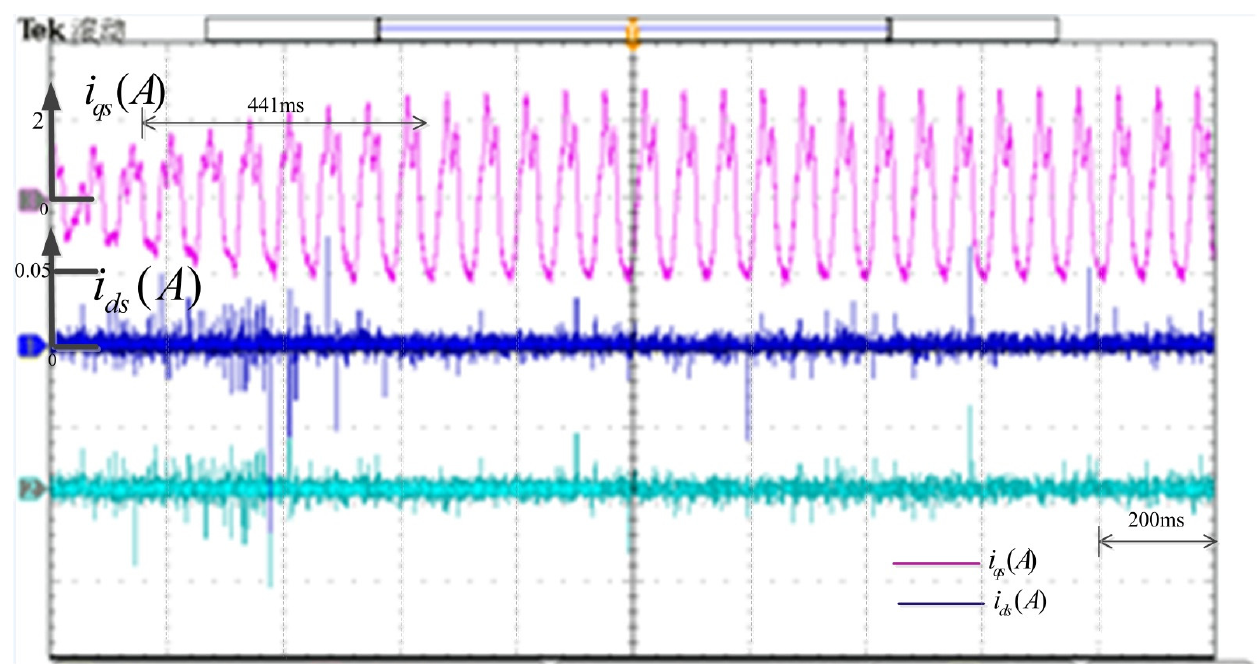
Figure 7. The validation results of the adaptive PI + RBFNN-PID control strategy for the load torque of the system abruptly changing under inductance parameters L d = 0.8ˆ L d , L q = 1.2ˆ L q . The top plot displays the q -axis stator current ( i qs ), and the bottom plot displays the d -axis stator current ( i ds ).